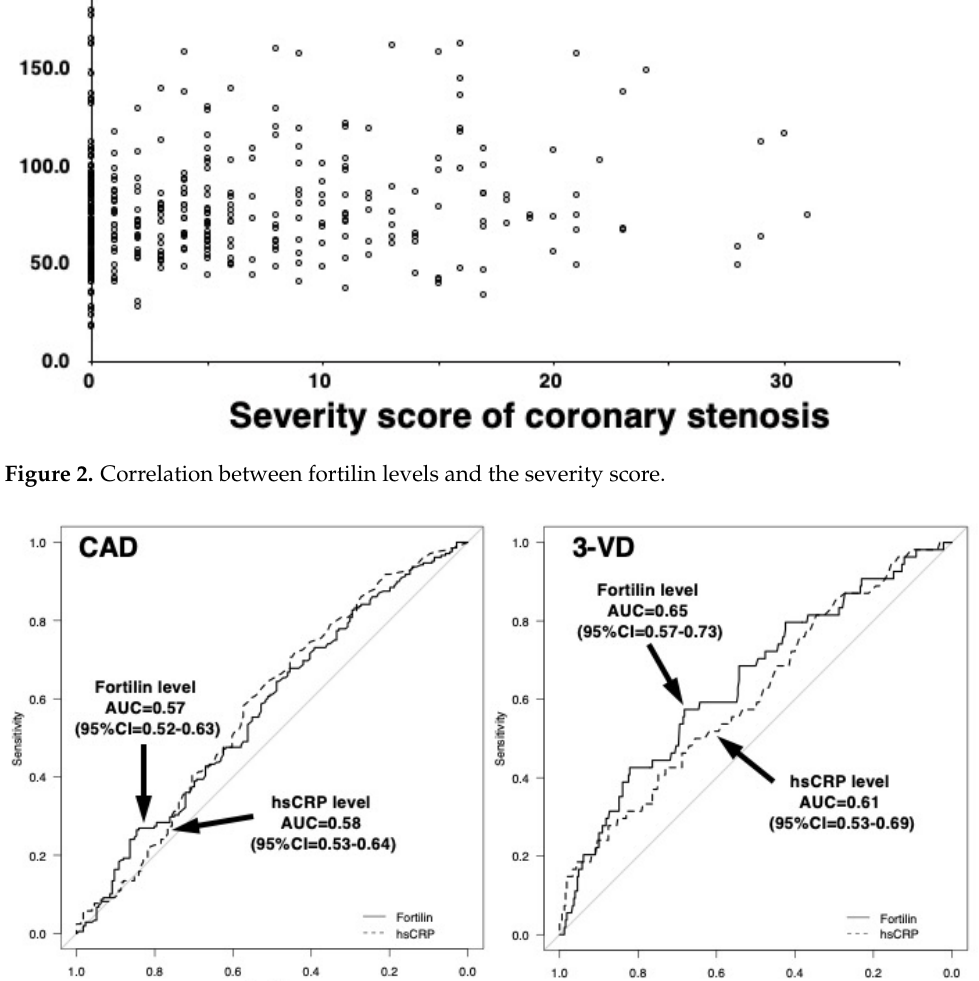
Figure 3. Receiver–operating characteristic (ROC) curves of fortilin and CRP levels for predicting the presence of CAD or 3VD. For the prediction of CAD, the areas under the curves (AUCs) for the fortilin and CRP levels were 0.57 (95%CI = 0.52–0.63) and 0.58 (95%CI = 0.53–0.64). For the prediction of 3VD, the AUC for fortilin was 0.65 (95%CI = 0.57–0.73), which tended to be larger than that for CRP (0.61; 95%CI = 0.53–0.69). Table 2. Factors for CAD and 3VD.